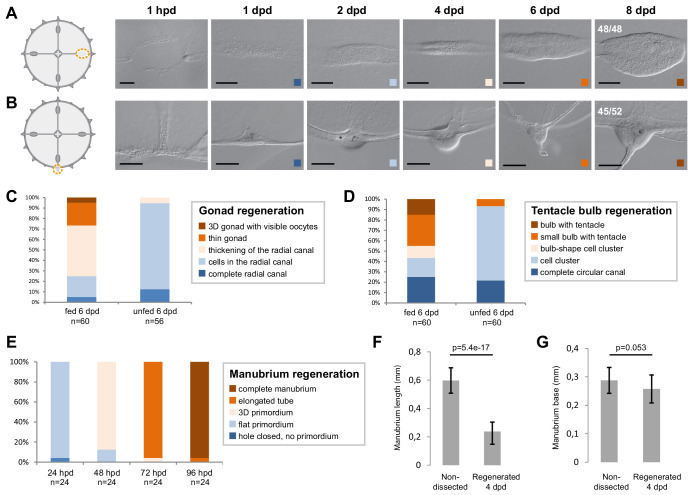
Organ regeneration in relation to feeding status.(A,B) Examples of organ ablation in fed individuals, each illustrated by a cartoon showing the cut (as an orange dotted line) and images of the regenerate at successive times. The regenerated gonad (A) and tentacle bulb (B) were both visible after 6 days. (C–E) Quantification of regeneration of gonads, tentacle bulbs and manubria, respectively, in fed versus unfed animals, as indicated. Both groups were fed 12 hr before the dissection, and fed animals were given Artemia every day until the end of the experiment. For gonads (C) and bulbs (D), regeneration rates were variable, but proceeded more reliably in fed jellyfish. (E) Manubrium regeneration was highly stereotypical. (F, G) Comparison of the dimension of endogenous versus regenerated manubria (4 dpd). The length from base to lip (F) was longer for endogenous manubria (n = 20 jellyfish), while their bases (G) were of comparable sizes. Statistics: two tailed t-test. Raw data for (C–G): Figure 1—figure supplement 1—source data 1. The images in A and B are also shown in Figure 1F and G, respectively. Scale bars: 100 µm.Figure 1—figure supplement 1—source data 1.Raw data for the plots shown in Figure 1—figure supplement 1C–G.